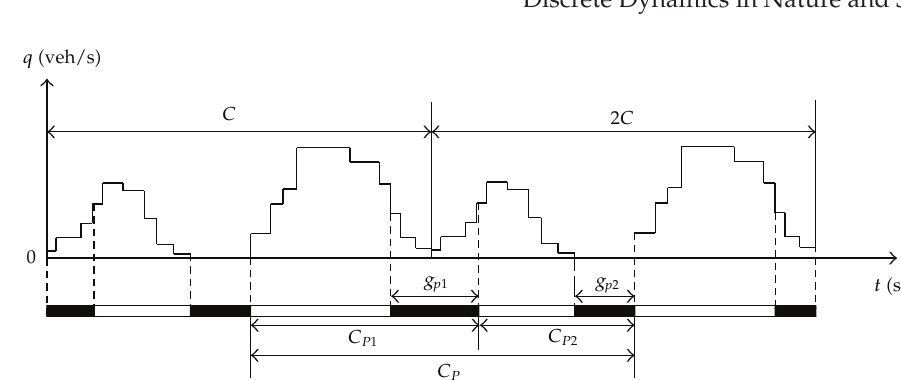
Figure 4: The establishment of first system optimal model on the basis of vehicle flow-time of crosswalk (cid:4) signal double cycles of pedestrian (cid:5) .